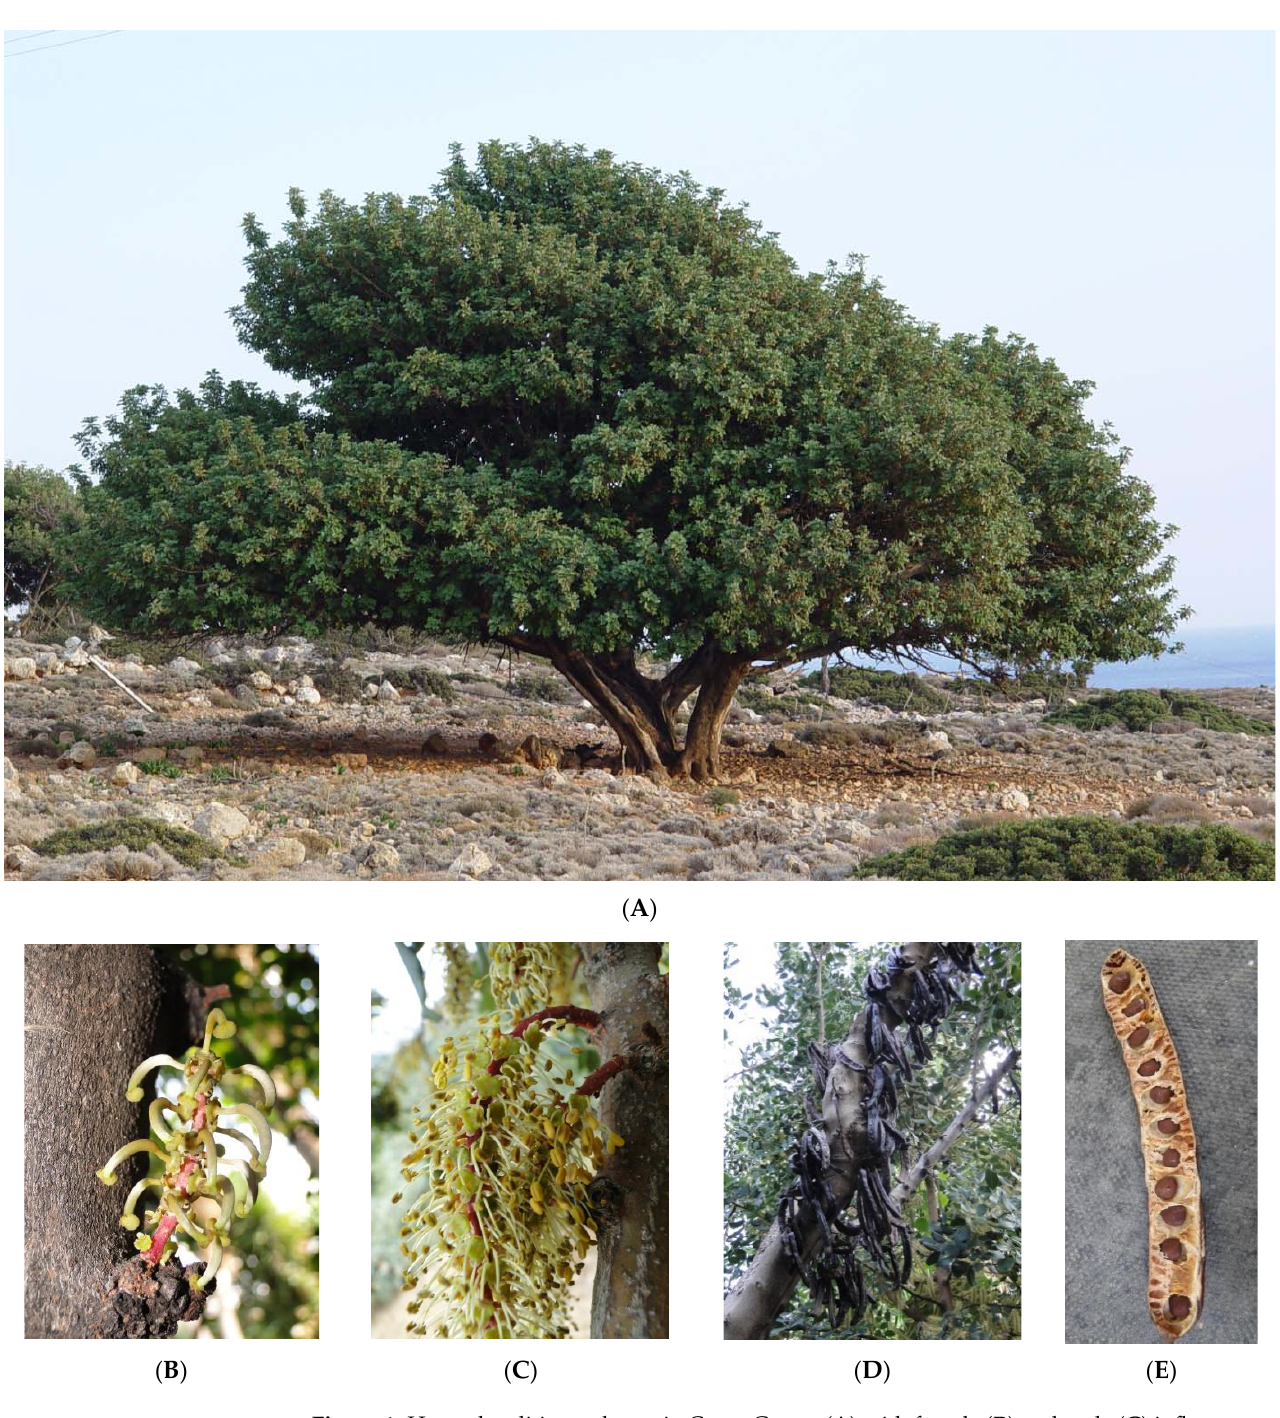
Figure 1. Hermphroditic carob tree in Crete, Greece ( A ) with female ( B ) and male ( C ) inflorescences, and carob pods ( D ) with mature seeds ( E ).